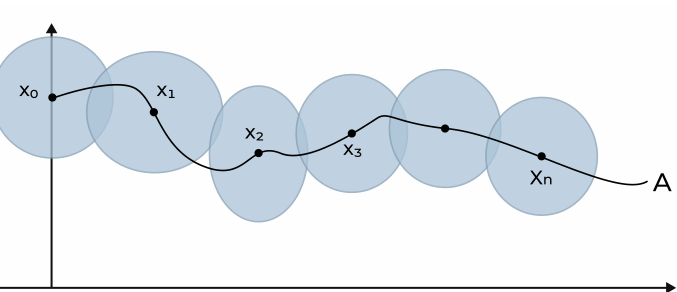
Figure 3. Collection of linearization points x 0 , x 1 , x 2 and x 3 in a 2D state-space. Blue circles denote suitable regions for use at each linearization point. Trajectory A is called the training trajectory.